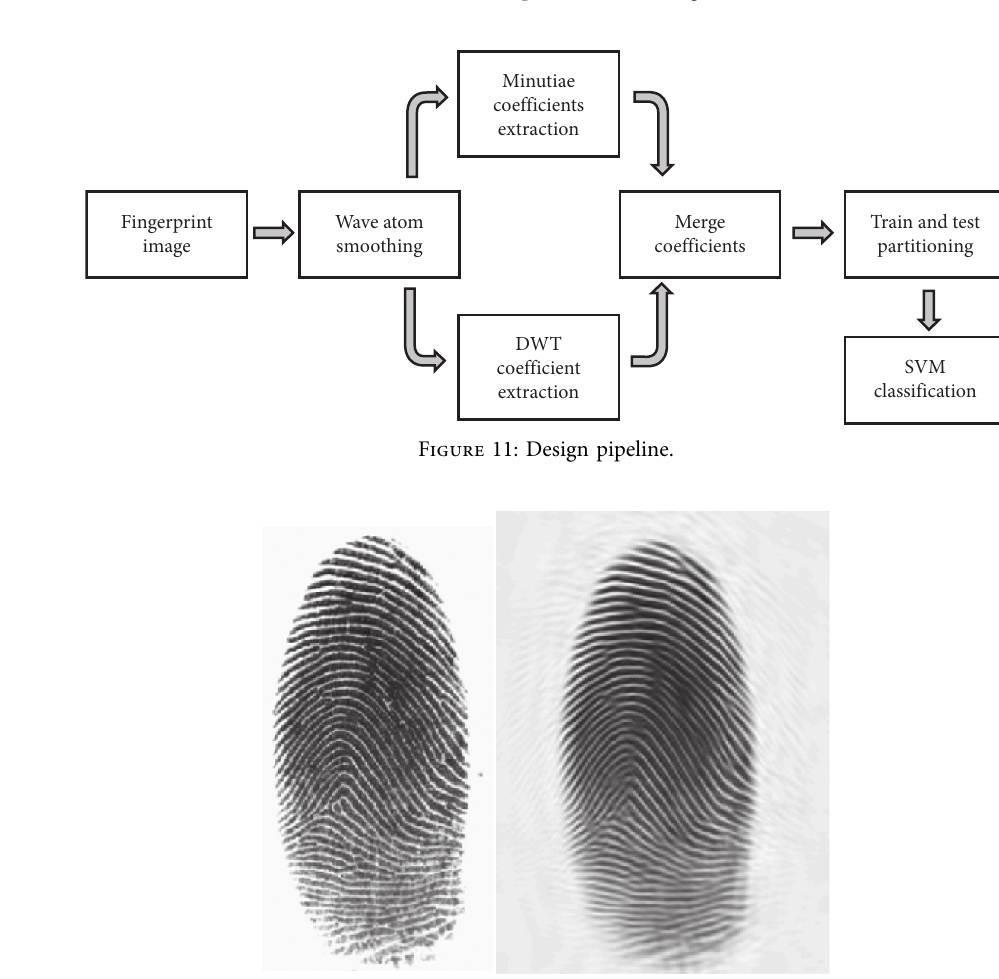
Figure 10: The 8 impressions from finger 101.